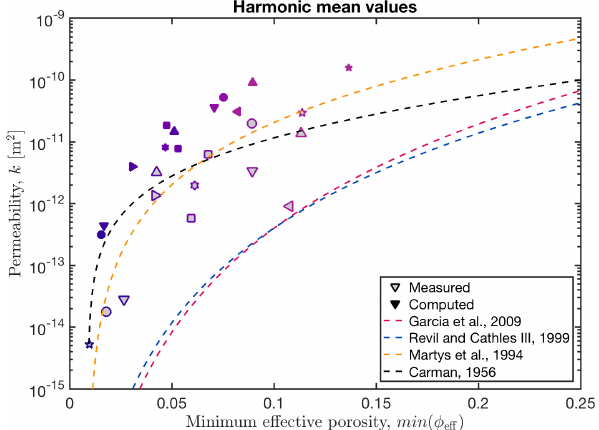
Figure E1. Computed and measured permeability against minimum effective porosity. Symbols of the same shape and colour represent the same sample. Samples with a grey face represent measured val- ues, whereas colour-only symbols stand for computed subsamples. The computed permeabilities represent the harmonic mean values of all subsamples. To verify existing permeability parameteriza- tions, we plotted the relations of Revil and Cathles (1999), Garcia et al. (2009), Carman (1956), and Martys et al. (1994) against the experimental and numerical permeabilities. Note that estimated er- rors for the experimental permeability measurements (Table 1a) are smaller than the displayed symbols.